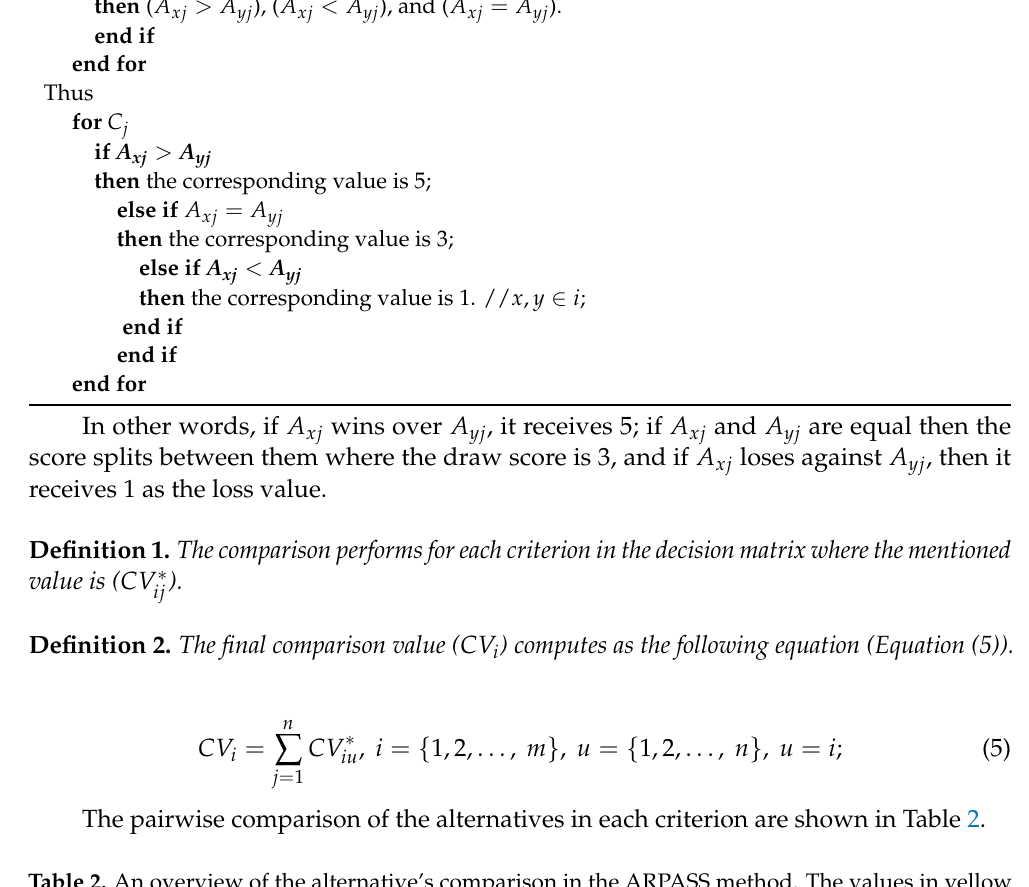
Table 2. An overview of the alternative’s comparison in the ARPASS method. The values in yellow cells are the repetition of the equations.